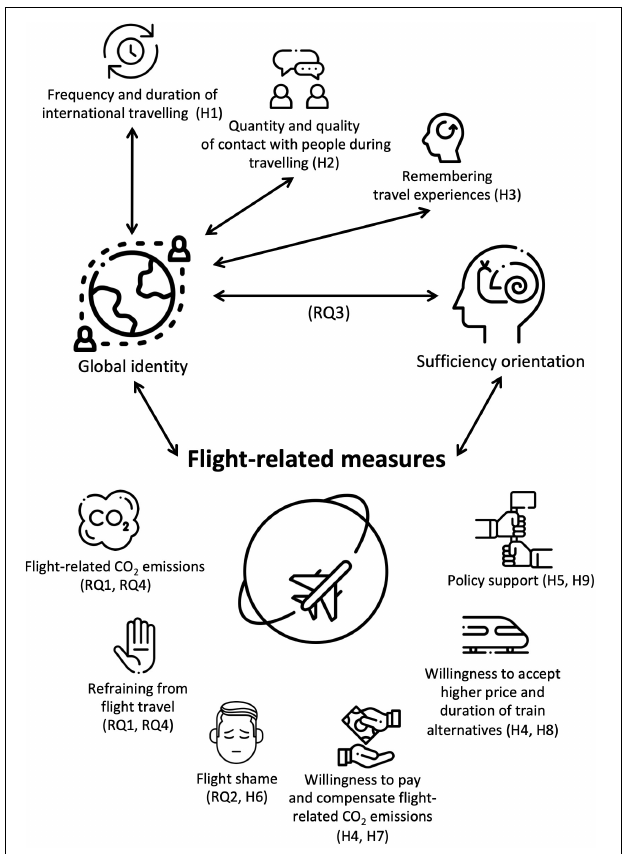
FIGURE 1 | Graphical overview of research questions and hypotheses. RQ, research question; H, hypothesis. This graphical illustration has been designed using resources from Flaticon.com. Icons are by Freepik (www.freepik.com), Dan Darius (www.flaticon.com/authors/darius-dan), Pixel perfect (www.flaticon.com/authors/pixel-perfect), and Pixelmeetup